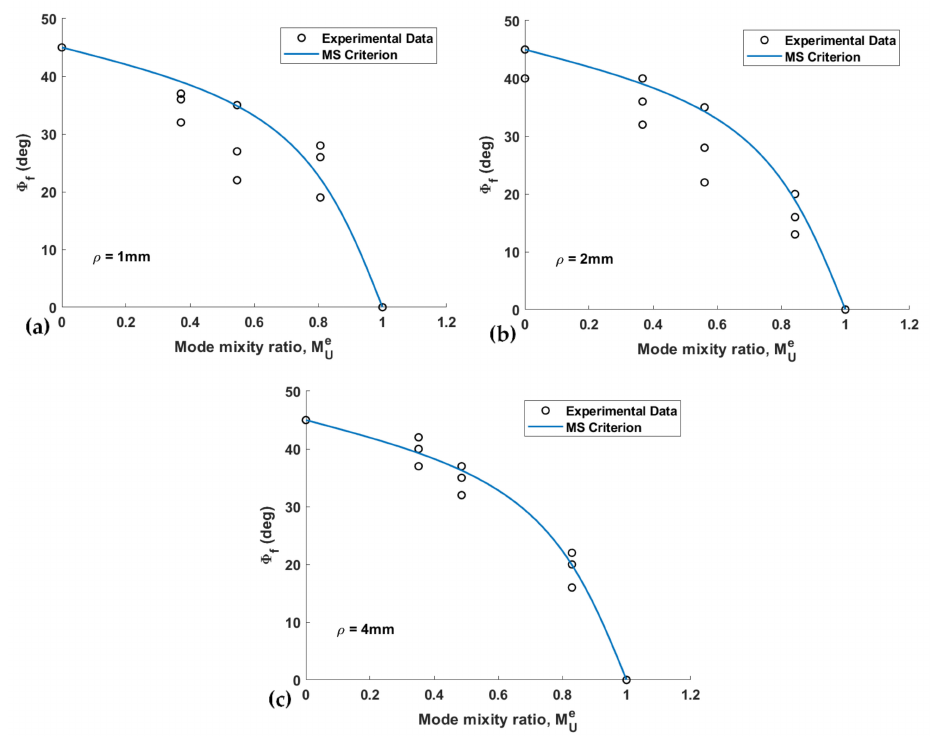
Figure 14. Out-of-plane fracture angle predicted by the MS criterion and corresponding experimental